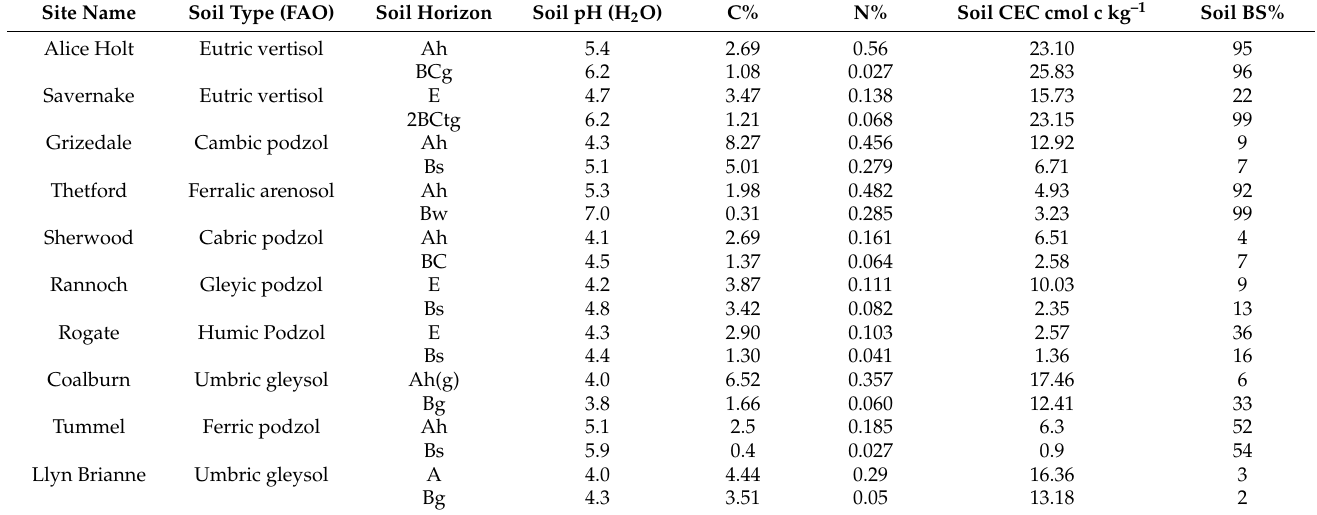
Table 2. Soil type and soil horizon related pH, carbon (C), nitrogen (N), cation exchange capacity (CEC by BaCl 2 extraction method) and base saturation (BS) of 10 Intensive Forest Monitoring Level II sites in the UK. Soil characteristics are shown only for the two horizons for each plot where the soil solution samplers are situated.